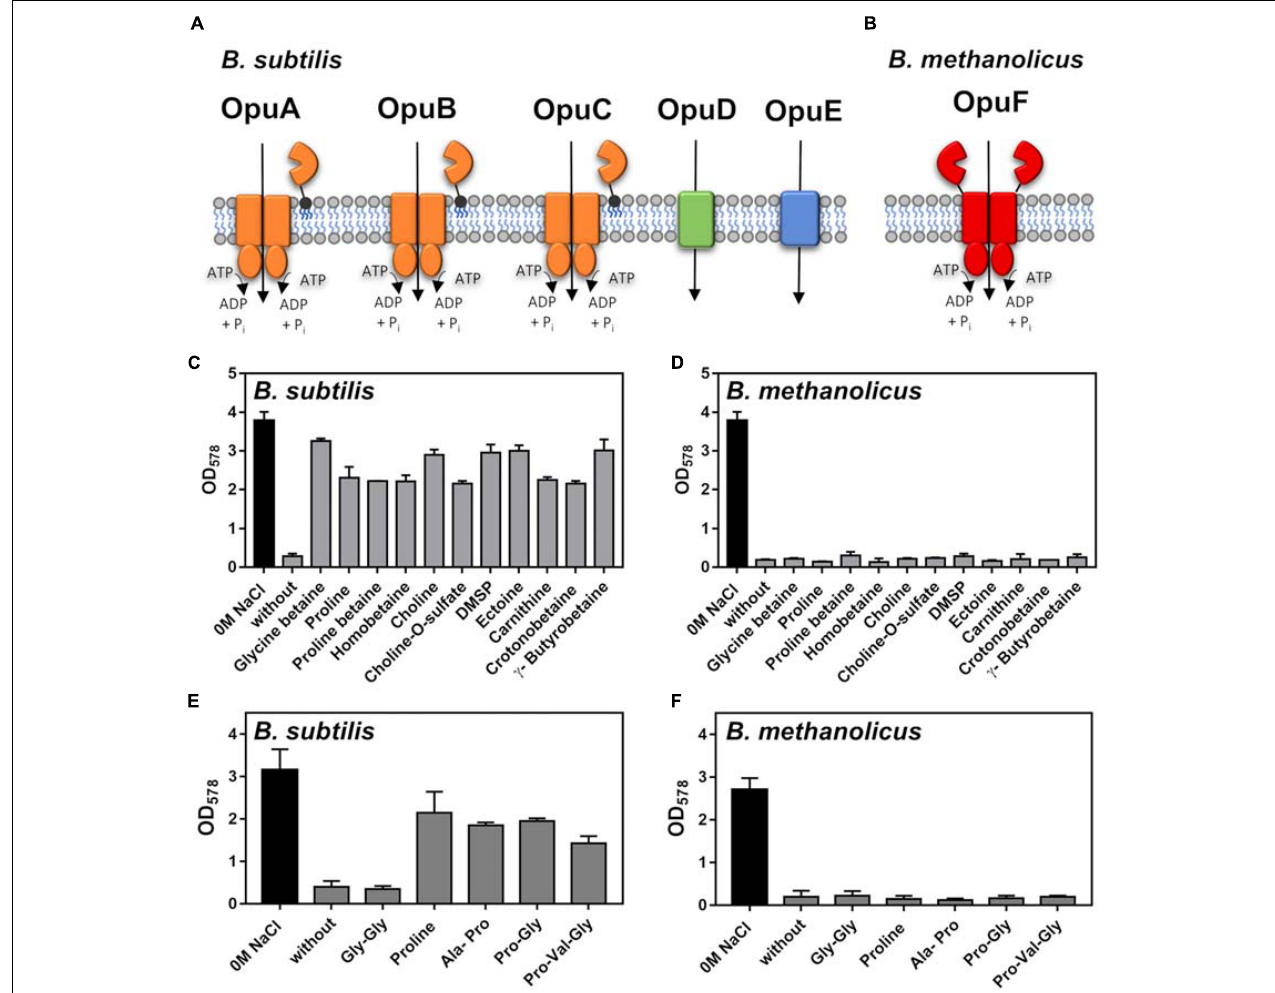
FIGURE 5 | Osmostress protection of Bacillus subtilis JH642 and Bacillus methanolicus MGA3 by externally provided compatible solutes and proline-containing peptides. (A) Schematic representation of the five Opu compatible solute transporters operating in B. subtilis (Hoffmann and Bremer, 2017) and (B) of the B. methanolicus MGA3 OpuF-type ABC transporter as deduced from the genome sequence (Heggeset et al., 2012) and previous studies of this transporter family (Teichmann et al., 2018). (C) Cultures of B. subtilis JH642 were grown either in SMM or in SMM with a growth-inhibiting concentration of NaCl (1.2 M) in the absence or the presence of 1 mM of the indicated osmostress protectants. Growth of the cultures was monitored by measuring their OD 578 after 18 h of incubation at 37 ◦ C in a shaking water bath. The data shown were derived from two biological replicates. (D) Growth of B. methanolicus MGA3 at 50 ◦ C either in MVcM or in MVcM with a growth-inhibiting concentration of NaCl (0.6 M) in the absence or in the presence of 1 mM of the indicated osmostress protectants. The data shown were derived from two biological replicates. (E,F) Growth of (E) the B. subtilis strain GWB100 (at 37 ◦ C in SMM containing 1.2 M NaCl) and (F) B. methanolicus MGA3 [at 50 ◦ C in either in MVcM or in MVcM with a growth-inhibiting concentration of NaCl (0.6 M)] in the presence of 1 mM of L-proline or the L-proline-containing the indicated peptides. Growth of the cultures was monitored by measuring their OD 578 after 18 h of incubation. The data shown were derived from two biological